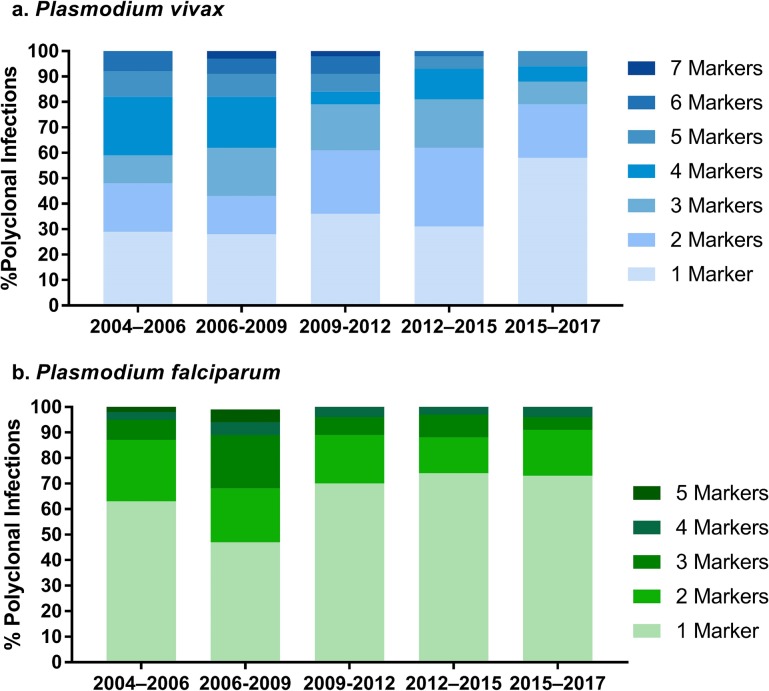
Proportion of multiallelic loci per infection (MLOCI) by temporal period.Bar charts illustrating the percentage of polyclonal infections with the given number of multiallelic loci for each of the 5 temporal periods in a) P. vivax and b) P. falciparum. Both species exhibit an overall decline over time in the percentage of infections with 2 or more multiallelic loci.